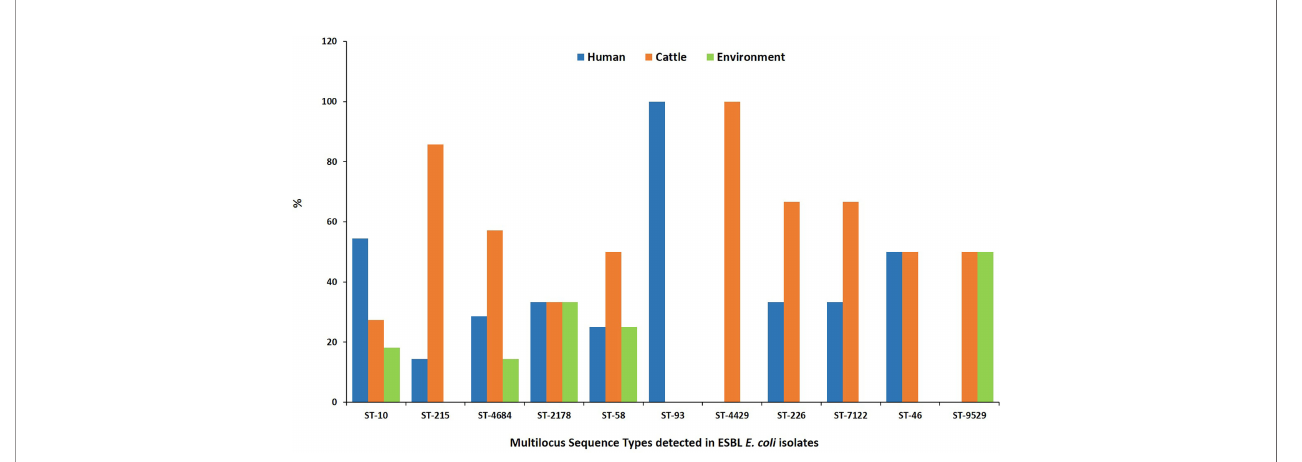
FIGURE 3 | Multilocus sequence types for ESBL-EC isolated from humans, beef cattle, and abattoir environments in Abuja and Lagos — Nigeria. Each bar represents the various ESBL-EC sequence types for isolates obtained from abattoir workers, beef cattle, and abattoir environments.